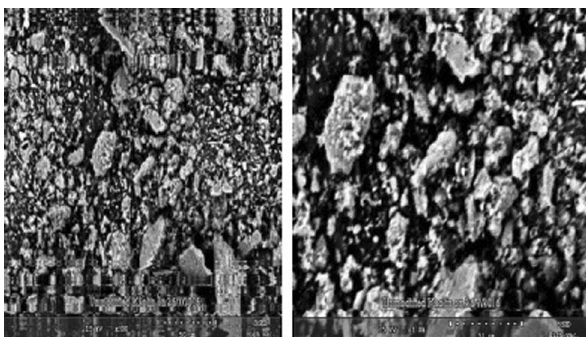
Fig. 3 SEM micrograph of UKC at × 500 and × 1000 magnifications